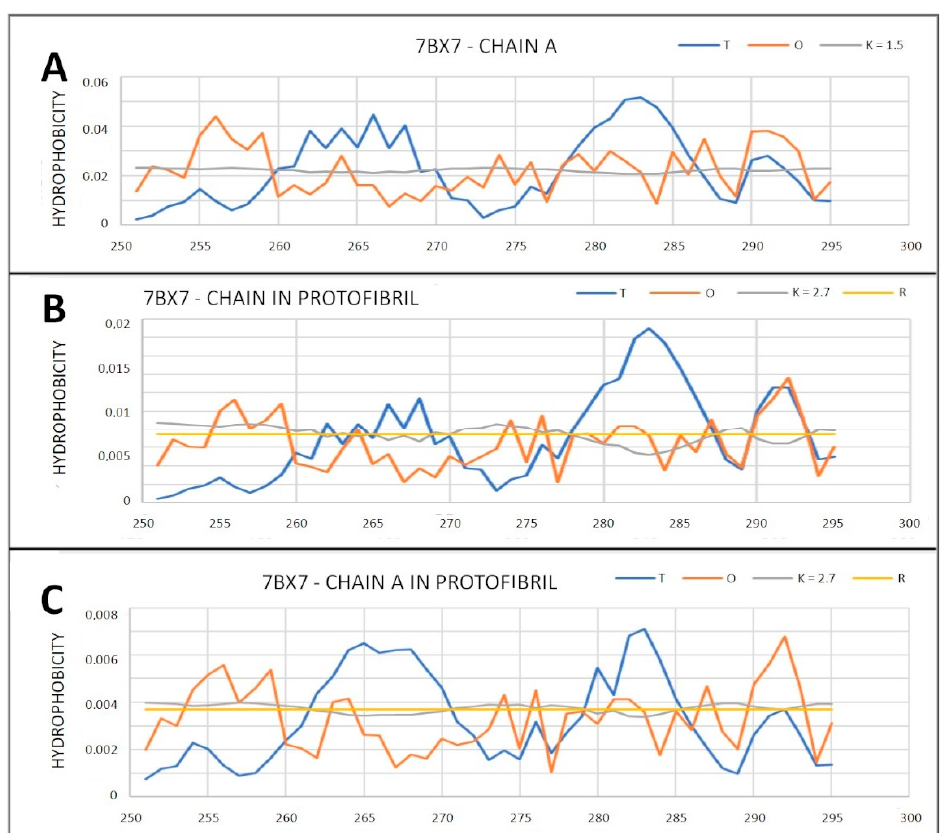
Figure 19. T, O and M profiles for determining amyloid status with PDB ID 7BX7. ( A ) Status of chain treated as an individual structural unit; ( B ) the status of the chain as a component of the proto-fibril; ( C ) the status of the chain as a component of a super-fibril.